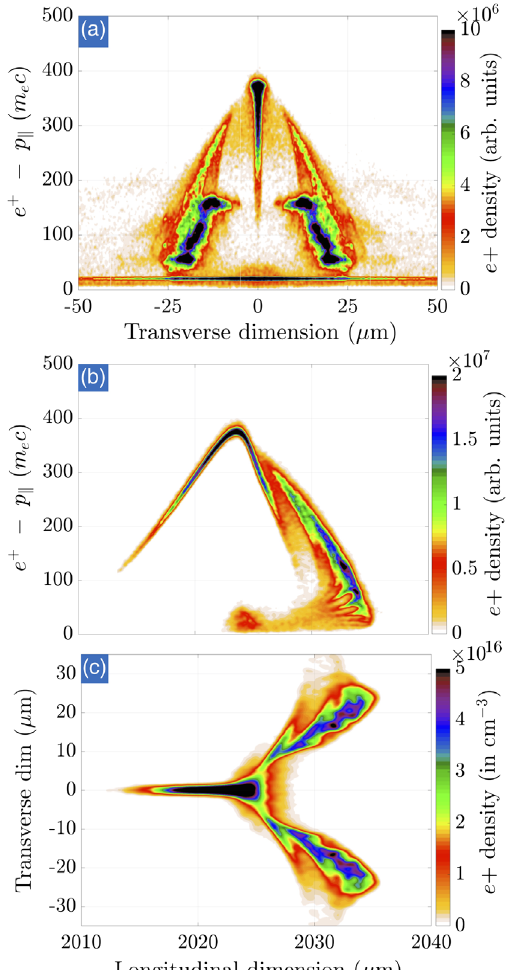
4. Phase-space slices of scheme-A e þ -beam correspond- ing to Figs. 2(c) and 2(d) — (a) p k -transverse space, (b) p k - longitudinal space, (c) transverse-longitudinal